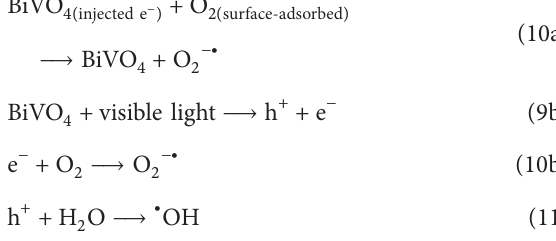
+ O BiVO 4( 2( surface-adsorbed ) injected e − ) 󳨀→ BiVO + O 2−∙ 4 + + BiVO 4 + visible light 󳨀→ h e